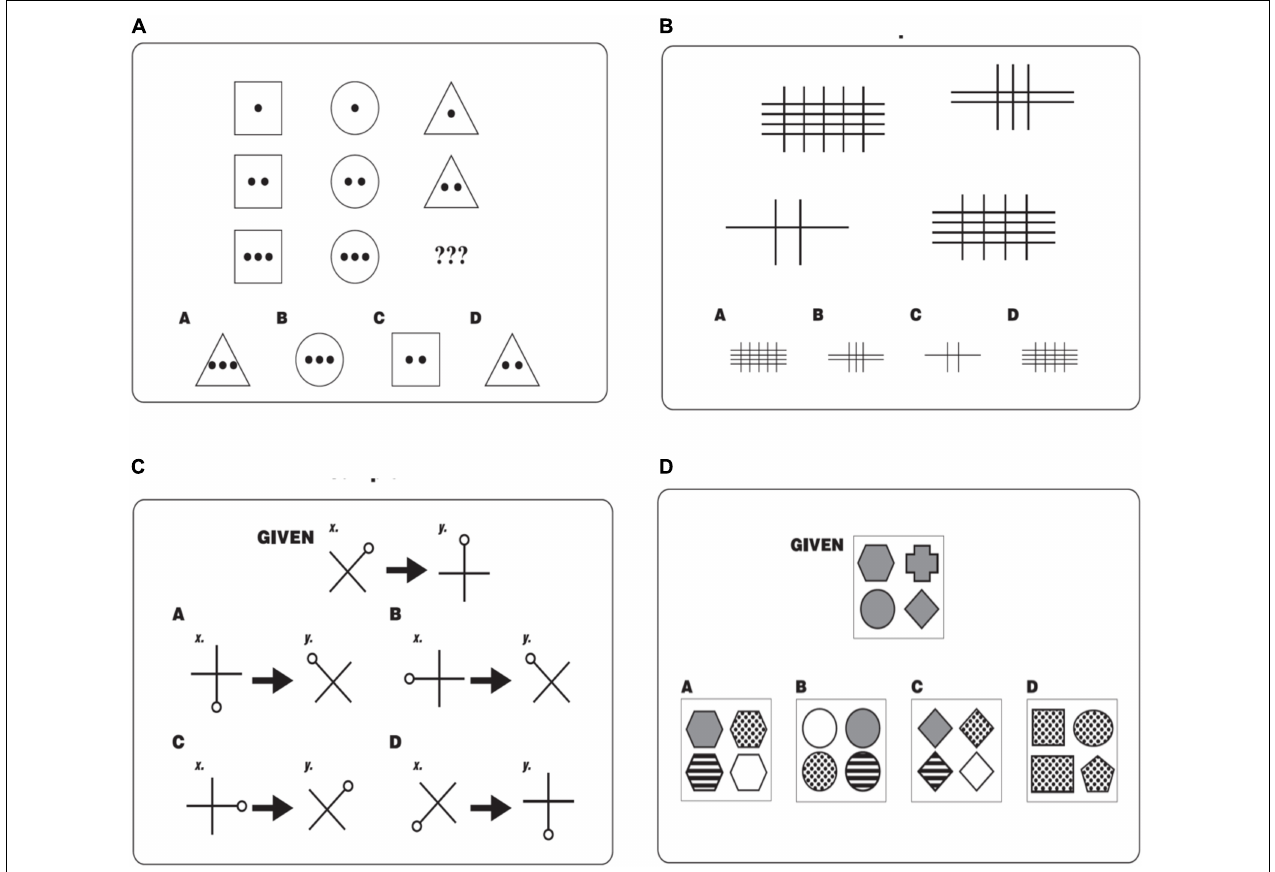
FIGURE 1 | Sample items from the analogy (A) , anomaly (B) , antithesis (C) , and antinomy (D) scales of the test of relational reasoning.